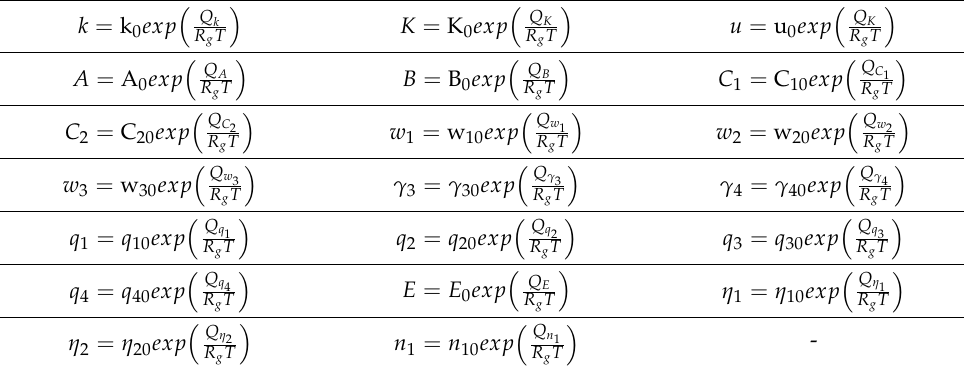
Table 3. The equation set of temperature-dependent material constants.